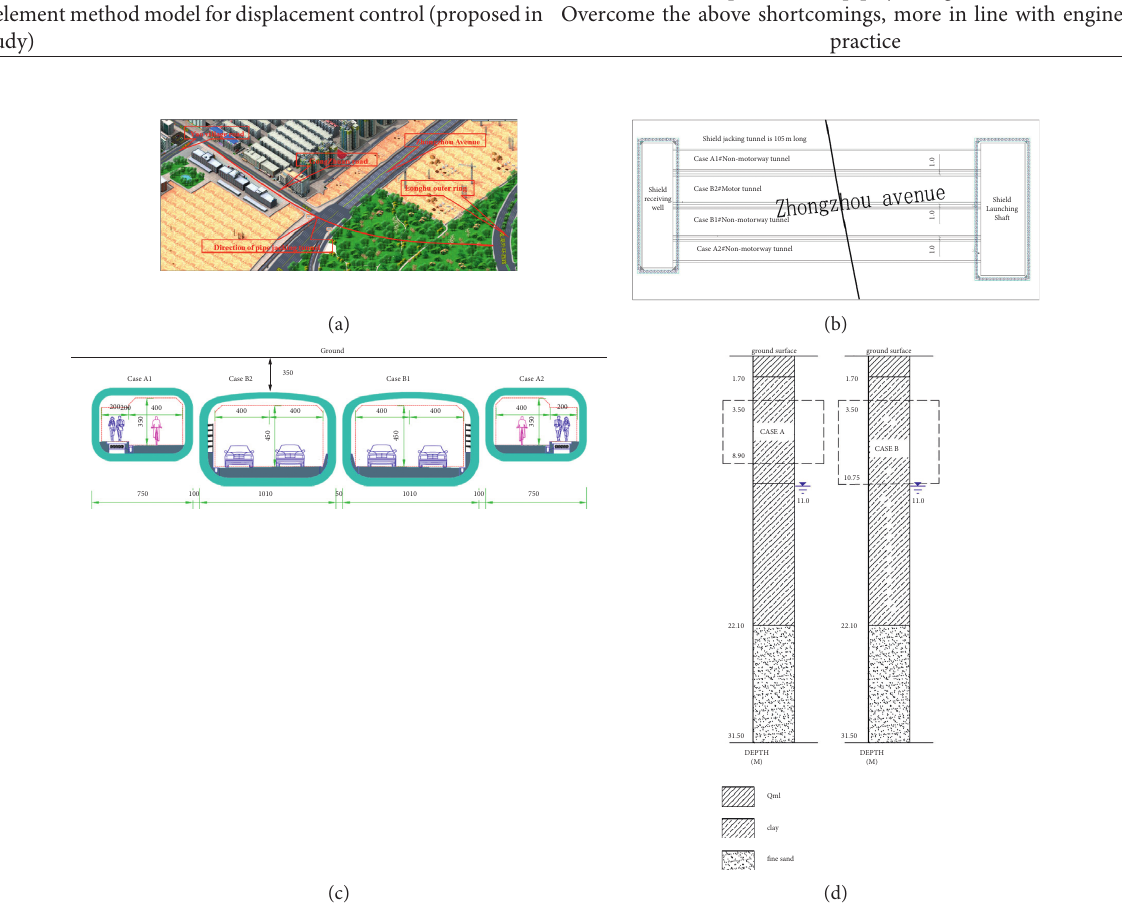
Figure 1: Locations and geology of the pipe jacking cases A and B. Table 2: The details of cases A1 and B1.